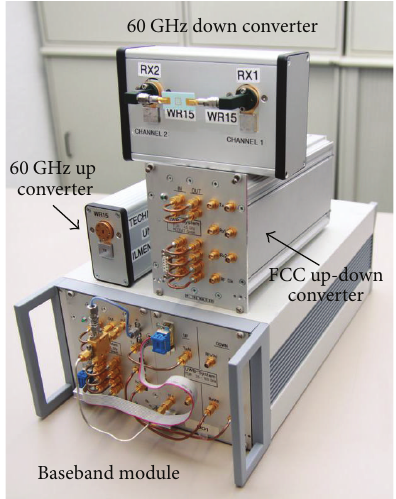
Figure 3: Examples of UWB baseband, FCC and 60GHz